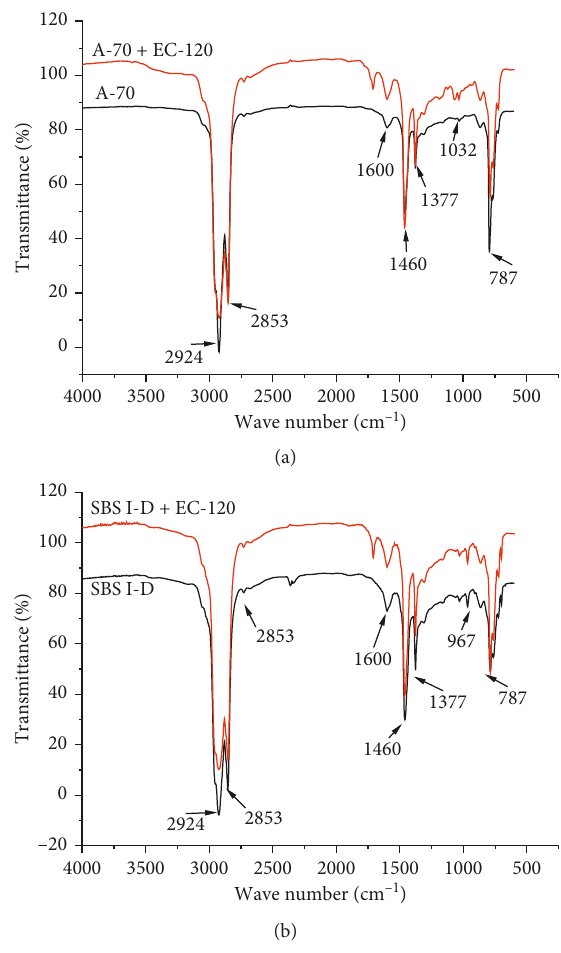
Figure 5: Infrared spectrums of base binder and warm-mixed binder. (a) A-70 and warm-mixed A-70. (b) SBS I-D and warm- mixed SBS